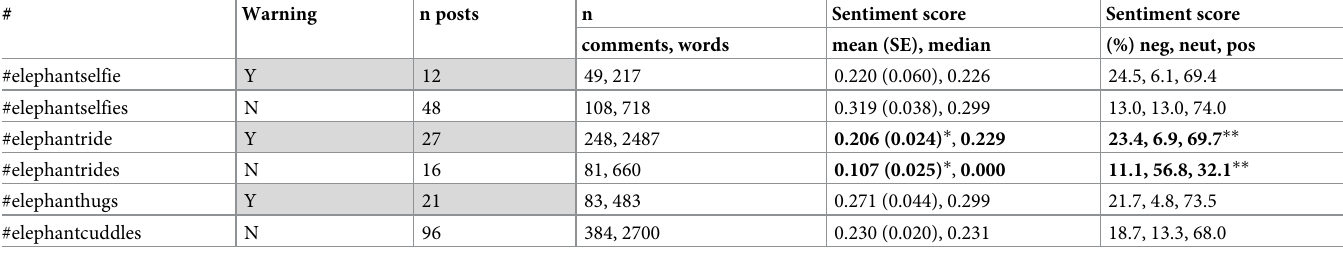
Table 3. Sentiment scores for comments to posts using each of six hashtags, where the first of each ‘pair’ of terms triggers Instagram’s warning and the second does not. Sentiment scores (assigned, based on text and emojis combined, using the “sentimentr” package (Rinker 2021) in R), reported as mean, SE, and median, and percent- age negative, neutral, and positive; sample size (n) is given as the number of posts, the total number of comments for all posts using each of the hashtags combined, and the number of words used in the analysis.